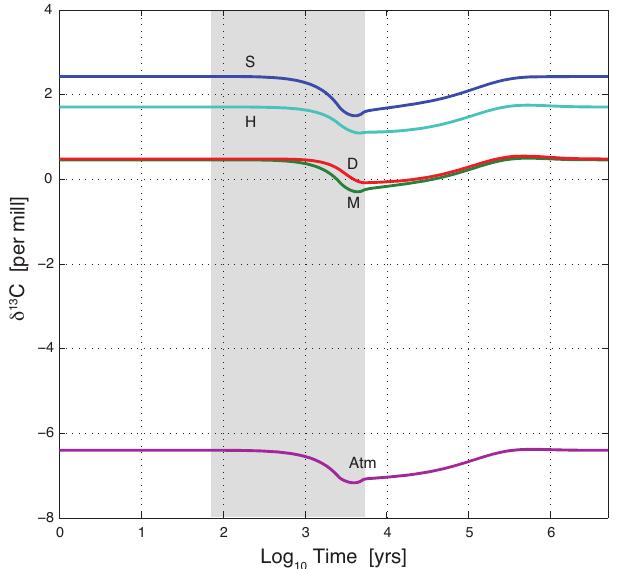
Figure 7. Carbon-13 isotope signature for the atmosphere (Atm) and ocean boxes as a function of time for the case of E = 1000PgC and D = 5kyr. The surface (S), intermediate (M), and deep (D) boxes were averaged for all basins. H is high-latitude box. Shaded region indicates time of emission.